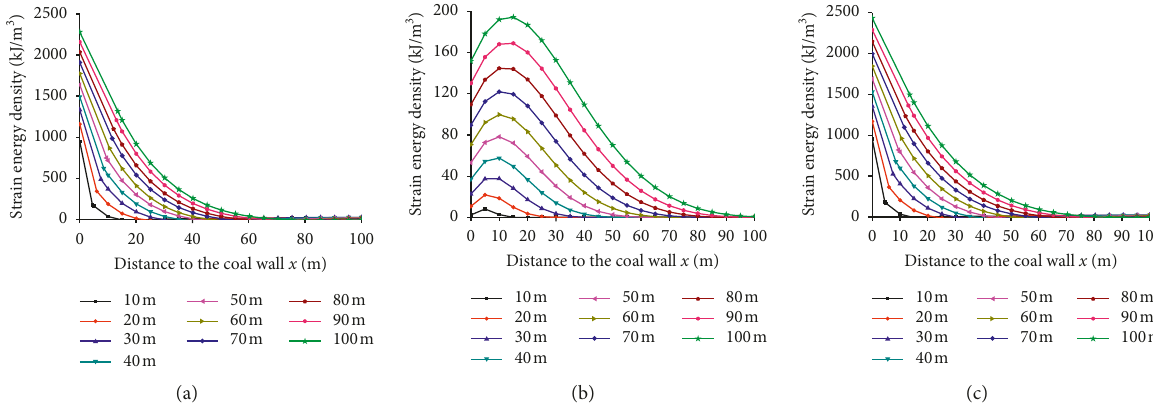
Figure 9: Strain energy density variation before and after the initial breakage event. (a) Coal mass. (b) Roof rock mass. (c) Overall working face.